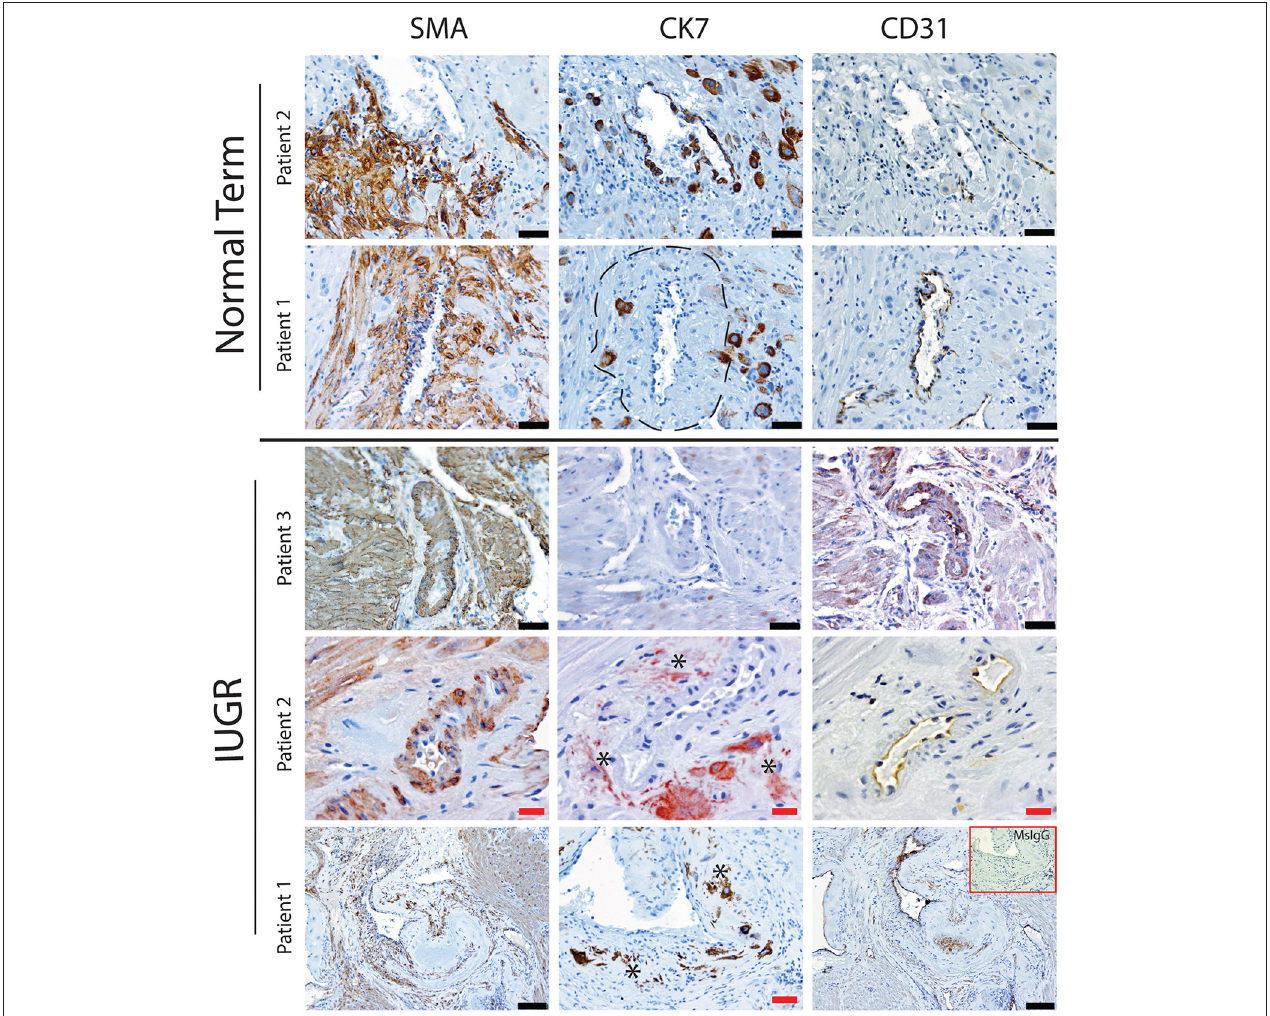
FIGURE 1 | Failed uterovascular transformation in IUGR is associated with persistance of vascular media and failure of interstitial and endovascular invasion. Immunohistochemical staining was performed to determine the degree of uterine artery transformation in PBBx biopsies using antibodies against smooth muscle actin (SMA, Column 1) cytokeratin 7 (CK7, Column 2) and PECAM (CD31, Column 3). Representative serial sections of control ( n = 2/15) and IUGR PBBx ( n = 3/8) uterine spiral arteries at the decidual myometrial junction are shown. Asterisks denote the presence of fragmented likely apopototic mural EVT in the IUGR cases. Fibrin deposition in the fully transformed artery is shown in patient 1 Normal marked by the hatched line. Negative control mouse IgG1 is shown in the inset lower right. Scale bars: black = 50 µ M, 100x magnification; red = 20 µ M,